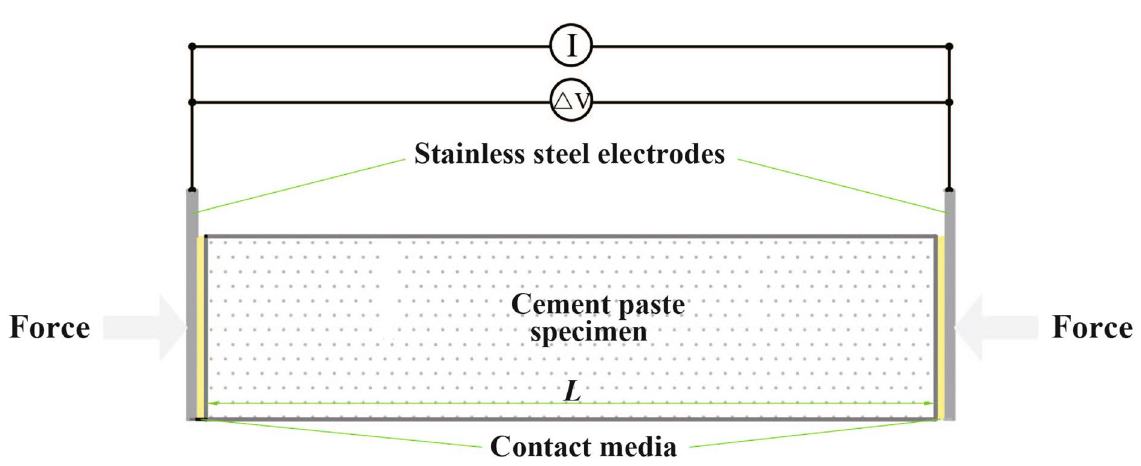
Figure 3. Cross-section of the two-point